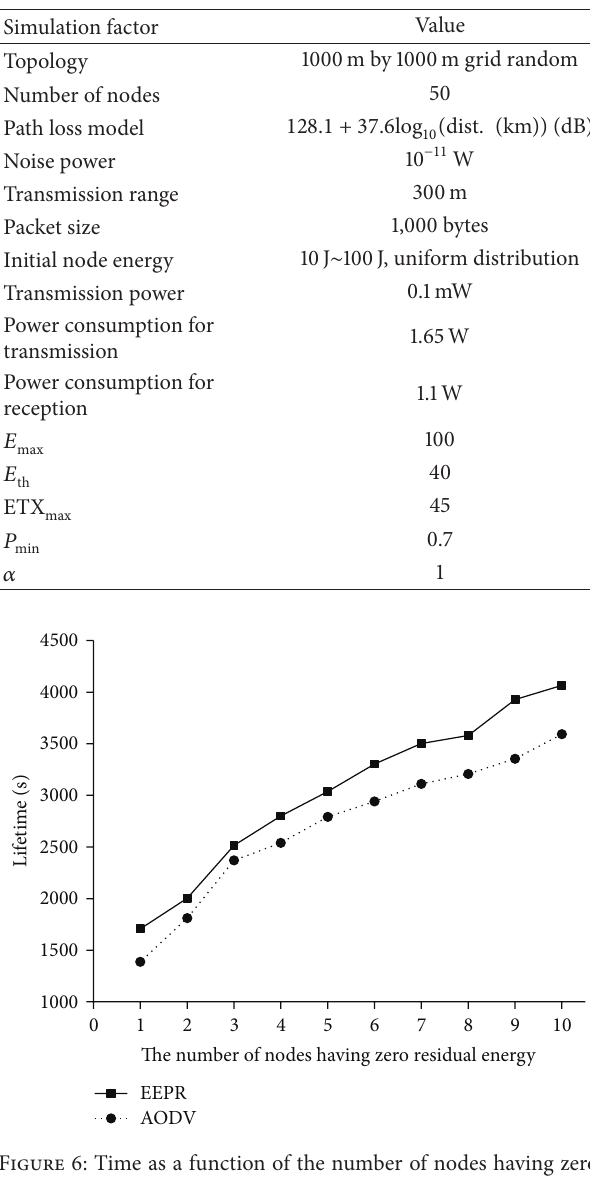
Table 1: Factors used in the simulation.